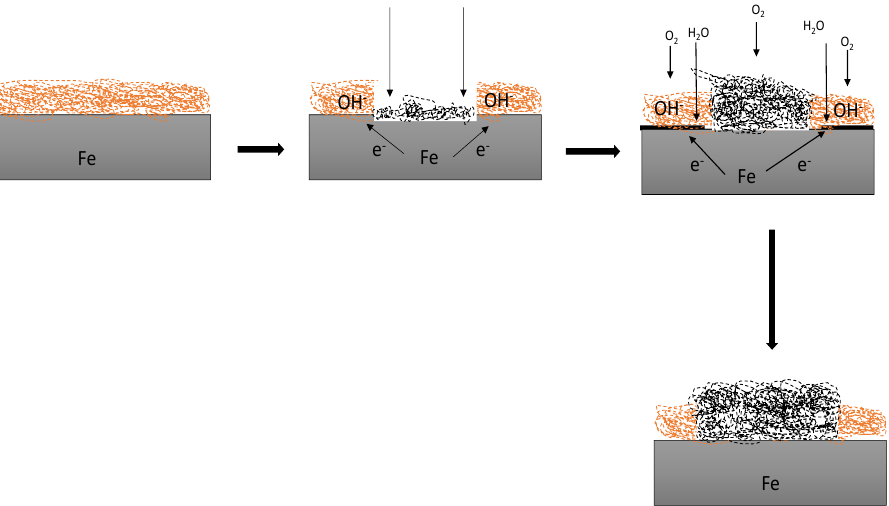
Figure 14 . The degradation mechanism of a coated metal exposed to NaCl for 30 days from the initial state, when there was an attack from the atmosphere and the resultant product with rust.